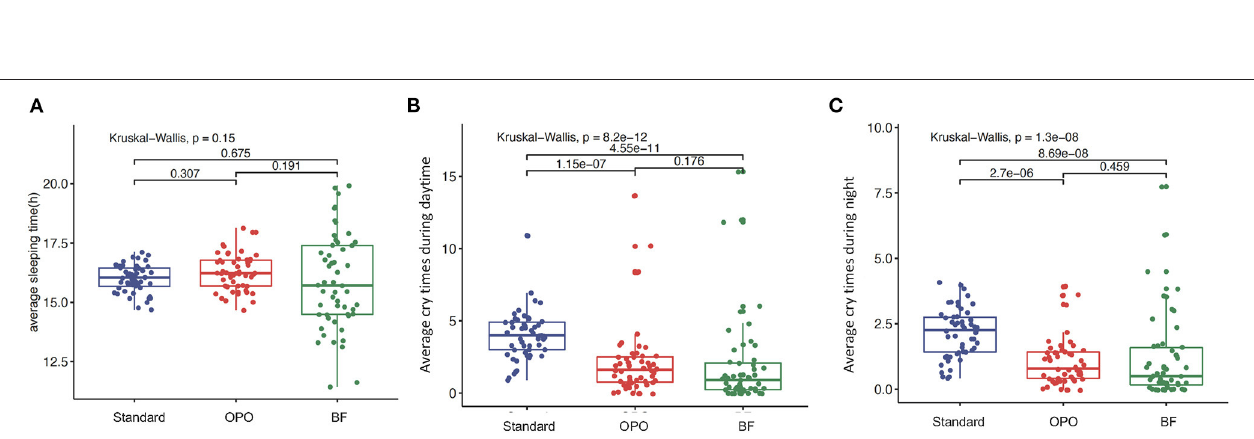
FIGURE 3 | Behavior status after feeding within 12 weeks among the three study groups. (A) Average sleeping duration. (B) frequencies of crying during the day. (C) frequencies of crying during the night. Data are presented as the mean (range). A p -value of less than 0.05 was considered statistically significant.